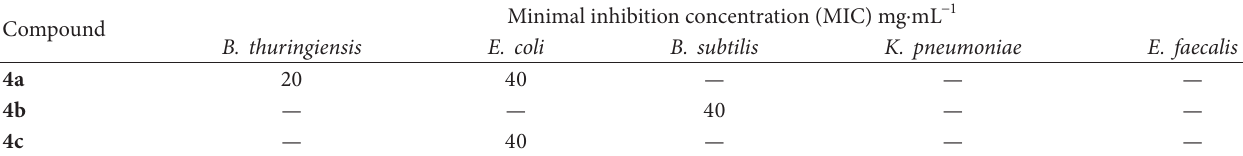
Table 3: Antimicrobial activity of the compounds using minimal inhibition concentration (MIC).